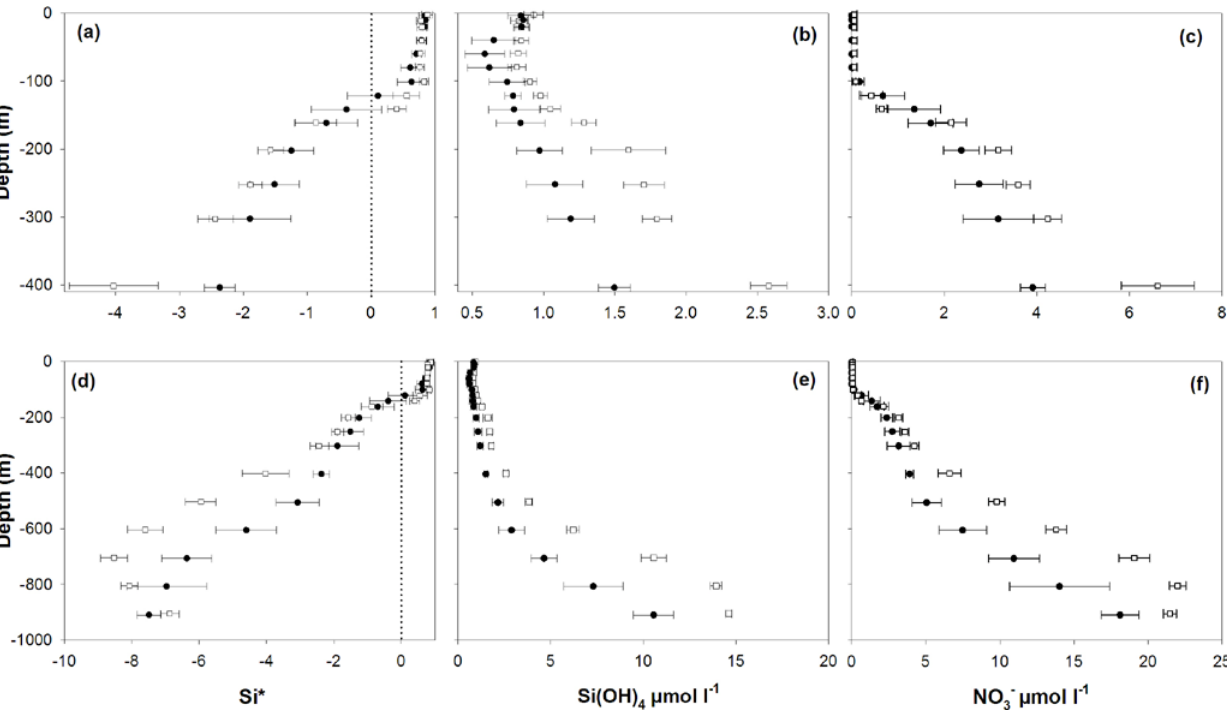
Fig. 4. Depth profiles of Si ∗ (µmoll − 1 ) , the concentration of silicate (Si(OH) 4 µmoll − 1 ) and the concentration of nitrate (NO − in eddy features that have affected the Bermuda Atlantic Time-Series Study (BATS) over the past decade. Si ∗ = 0 (µmoll − 1 ) is shown by a dotted line. Averages of six cyclonic (white squares) and four mode-water eddy (black circles) features are shown (standard error bars are shown on the graph). (a–c) show the depth profiles to 400m, while (d–f) show profiles to